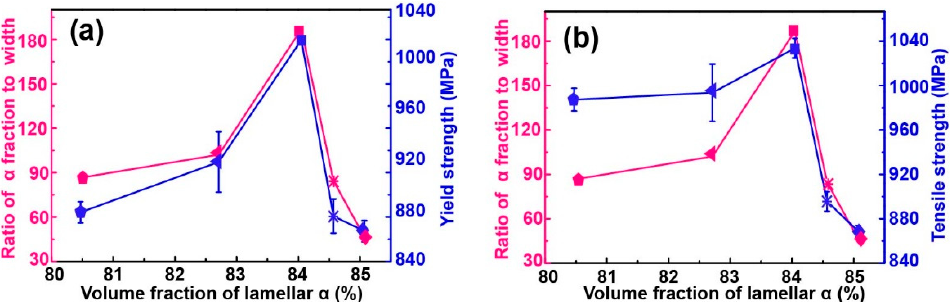
Figure 14. ( a ) Yield strength and α -fraction-to-width ratio varied with volume fraction of lamellar α . ( b ) Tensile strength and α -fraction-to-width ratio varied with volume fraction of lamellar α . Yield and tensile strengths were more closely related to α -fraction-to-width ratio.